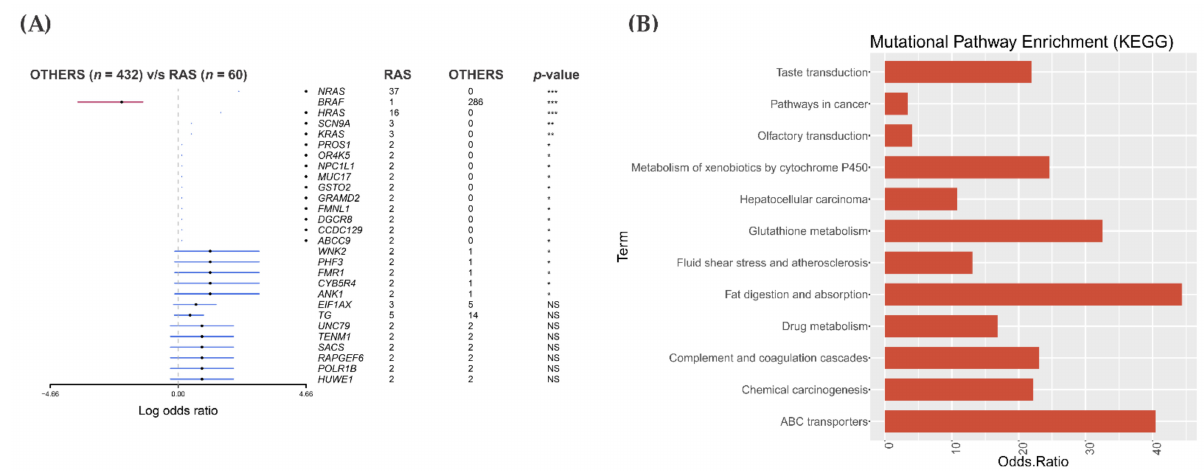
Figure 4. Mutational analysis and pathway enrichment (KEGG) in RAS -positive papillary thyroid carcinomas (PTC) from The Cancer Genome Atlas (TCGA) cohort. ( A ) A forest plot showing the eleven genes exclusively and recurrently mutated (present in at least two samples) in 60 RAS-positive samples. *** p -value ≤ 0.001, ** p -value ≤ 0.01, * p -value < 0.05, NS = non-significant p -value ( B ) KEGG pathway enrichment of the 11 exclusively mutated genes in rhe RAS-positive TCGA